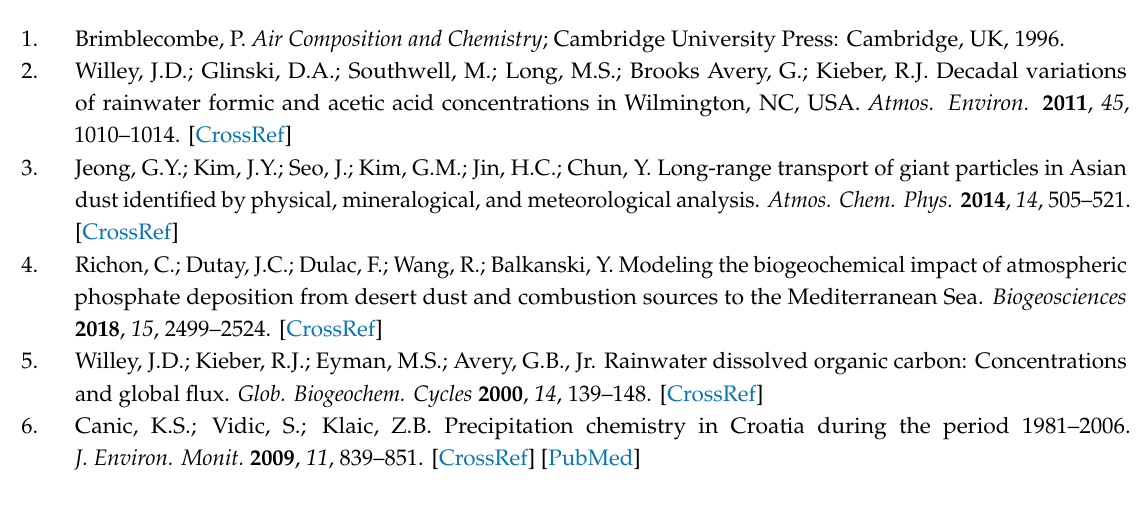
Figure S1: Copper complexing capacity (CuCC) in precipitation., Table S1: Performance of HR ICP-MS analyses: quality control (QC) as represented by analyzing certified standard reference materials “River Water Reference Material for Trace Metals” (SLRS-4, National Research Council Canada) (n = 11), the common level of procedural blanks and method Level of Quantification (LOQ). All values are provided in µ g / L, Table S2: Concentration of DOC and pH values in rainwater (Zagreb). Table S3: Correlation between DOC and metal concentrations in rainwater (Zagreb). Tabel S4: RSS concentration and type of interaction with Hg in rainwater samples. Tabel S5: Arithmetic means ( µ g / L), standard deviations (SD), median, minimum, maximum of trace elements in bulk samples (N = 19) of rainwater. Tabel S6: The relationship between metal concentrations and rainfall amounts. (Spearman correlation coe ffi cients, r and p values). Tabel S7: Spearman correlation matrix for the metals in rainwater